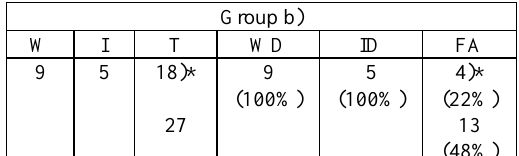
Result of the window detection for the two long planes, W = windows (ground truth), D = doors (ground truth), T = amount of detected windows, WD = correctly detected windows, DD = detected windows which are actually doors, FA = false alarm